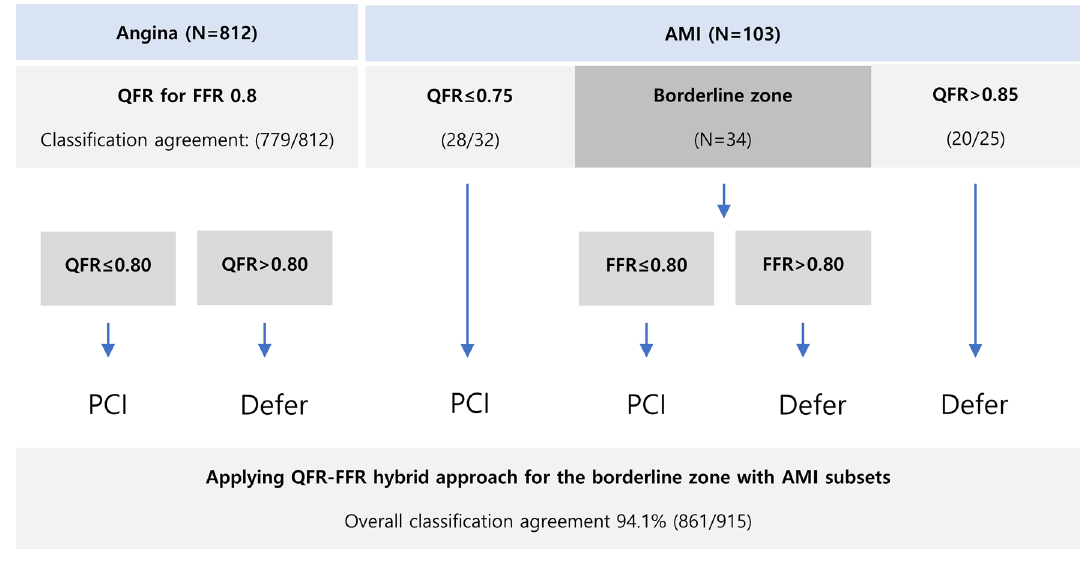
Figure 6. QFR-FFR Hybrid approach